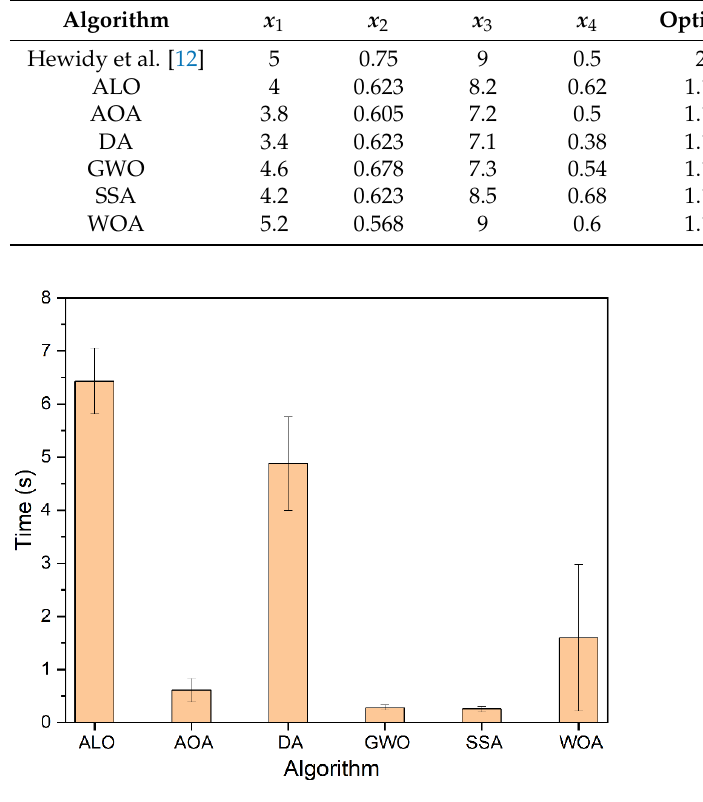
Figure 5 . Average time taken by the algorithms in the optimization of the responses. The bars and whiskers denote the mean and standard deviation of 10 runs (3 responses X 10 independent runs/response).